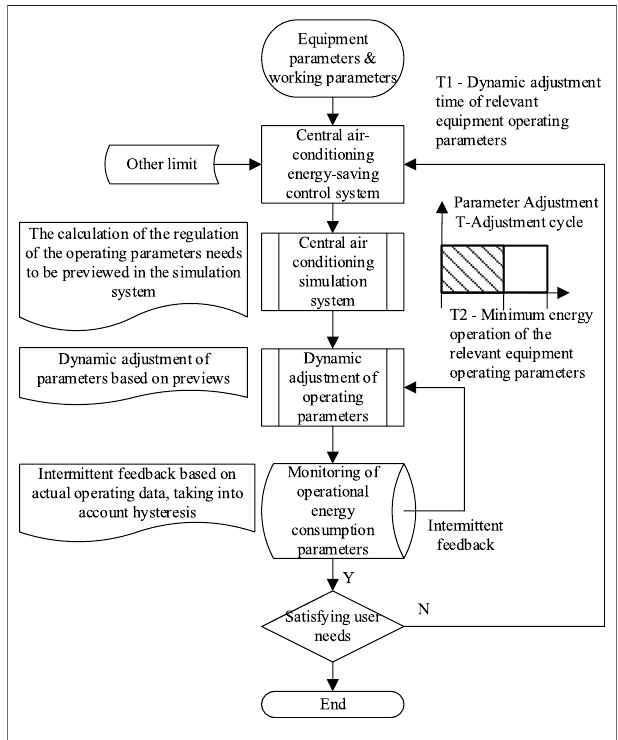
FIGURE 4 | Load limiting control